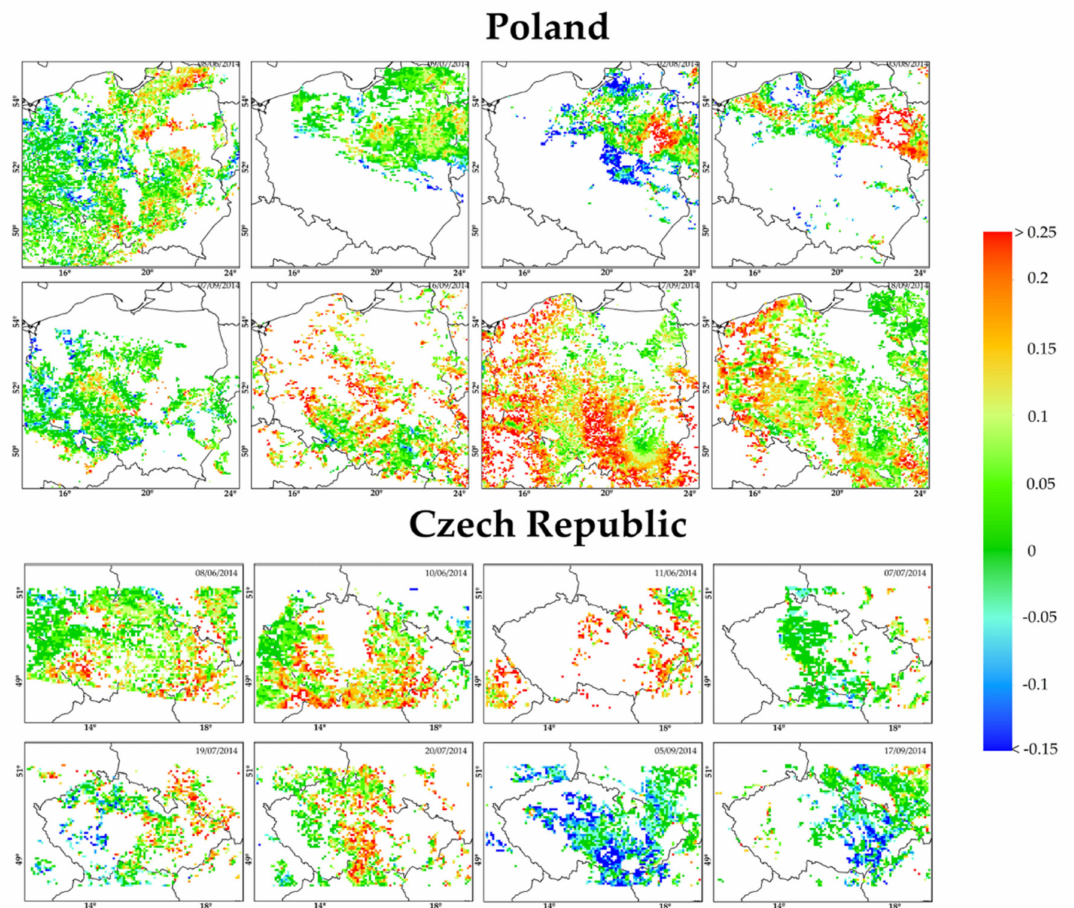
Figure 6. AOD differences between SEVIRI and MODIS for the Poland and Czech Republic